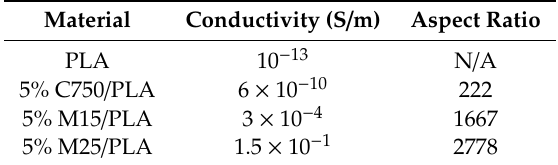
Table 1. Measured conductivity of xGNP/PLA composites and the reported aspect ratio of xGNP filler material.